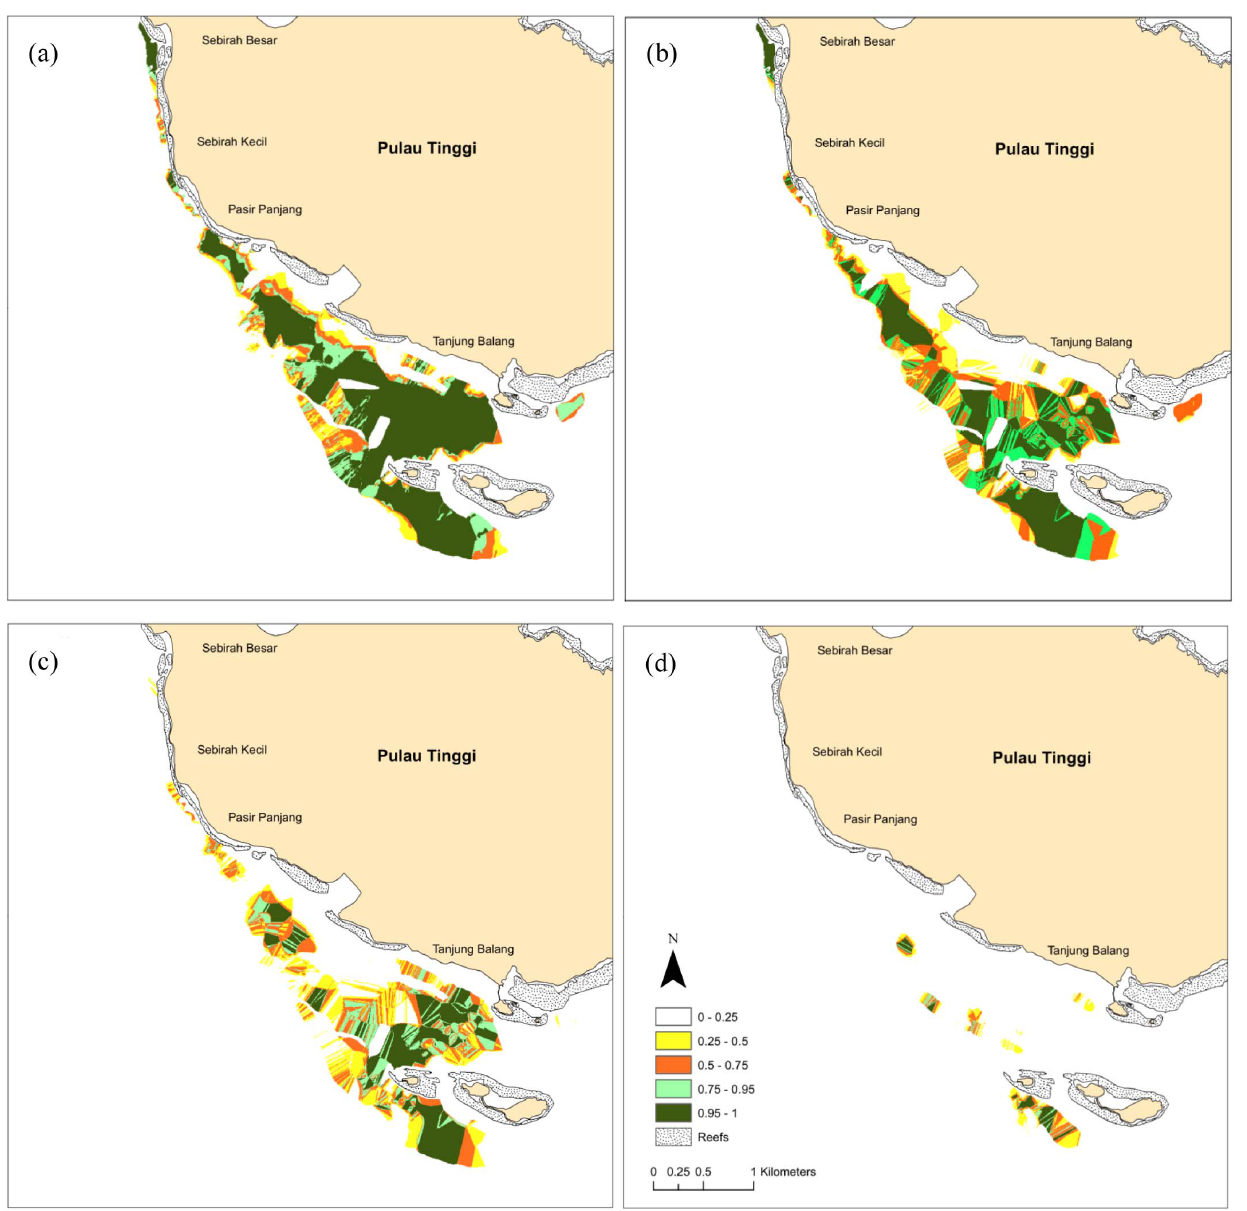
Figure 3. Probability estimates for the occurrence of (a) Halophila spp. (b) Halodule uninervis (c) Cymodocea serrulata , and (d) Syringodium isoetifolium in the southwest of Pulau Tinggi, Malaysia, produced by ordinary kriging in 5 m